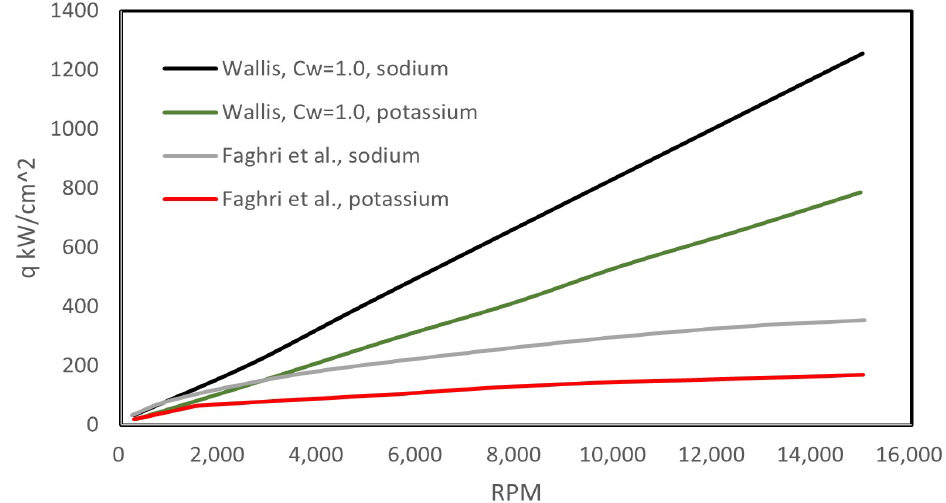
Figure 10. Entrainment limits as the function of rotational speed (data from [46]; lines correspond to the correlations by [48] and [49], as identified in the key).